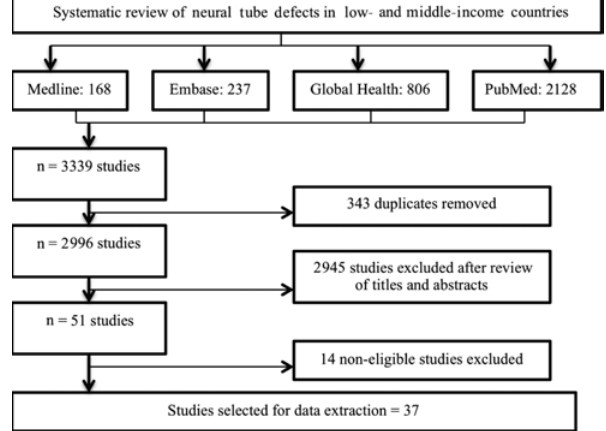
Figure 1. A summary of the process of literature